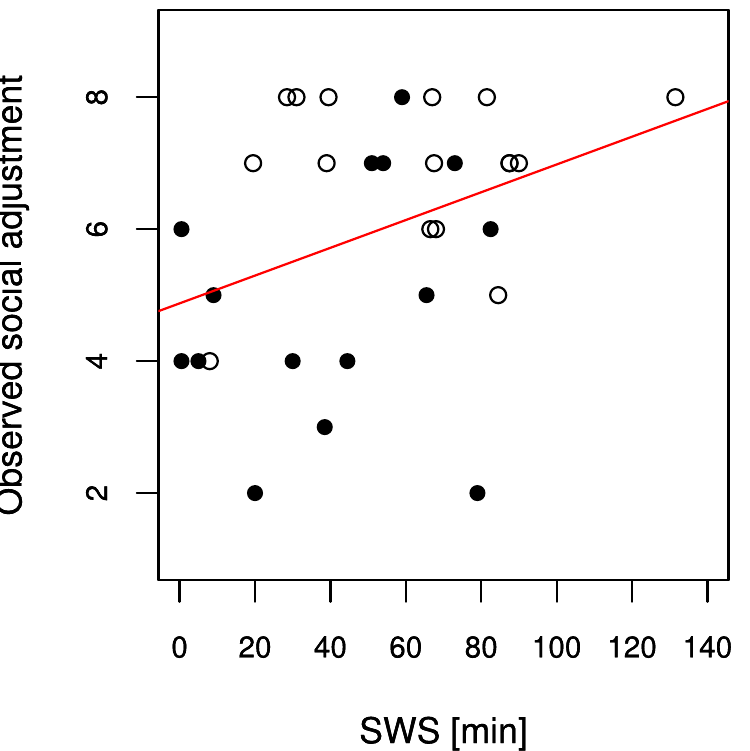
Fig 1. Regression plot of the exploratory sleep regression model. Stepwise variable selection of sleep stages (N1 sleep, N2 sleep, SWS, REM sleep) results in a significant regression model (p = 0.042; adjusted R 2 = 0.106) with SWS as the only significant predictor. The given scatterplot represents this positive linear relationship ( β = 0.368) between SWS and social functioning. Black dots represent PwS, black-edged white dots represent PwD. The red line represents the regression line of the respective